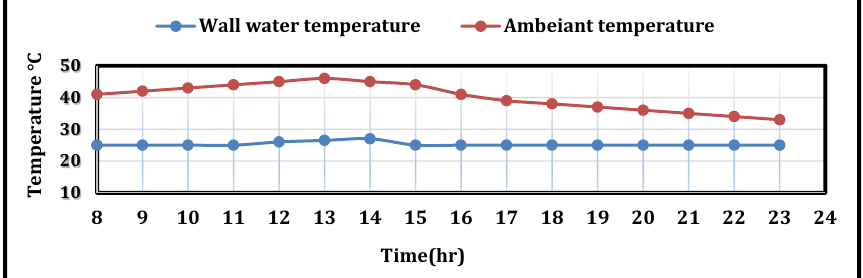
Figure 5: Water and ambient temperature with time.